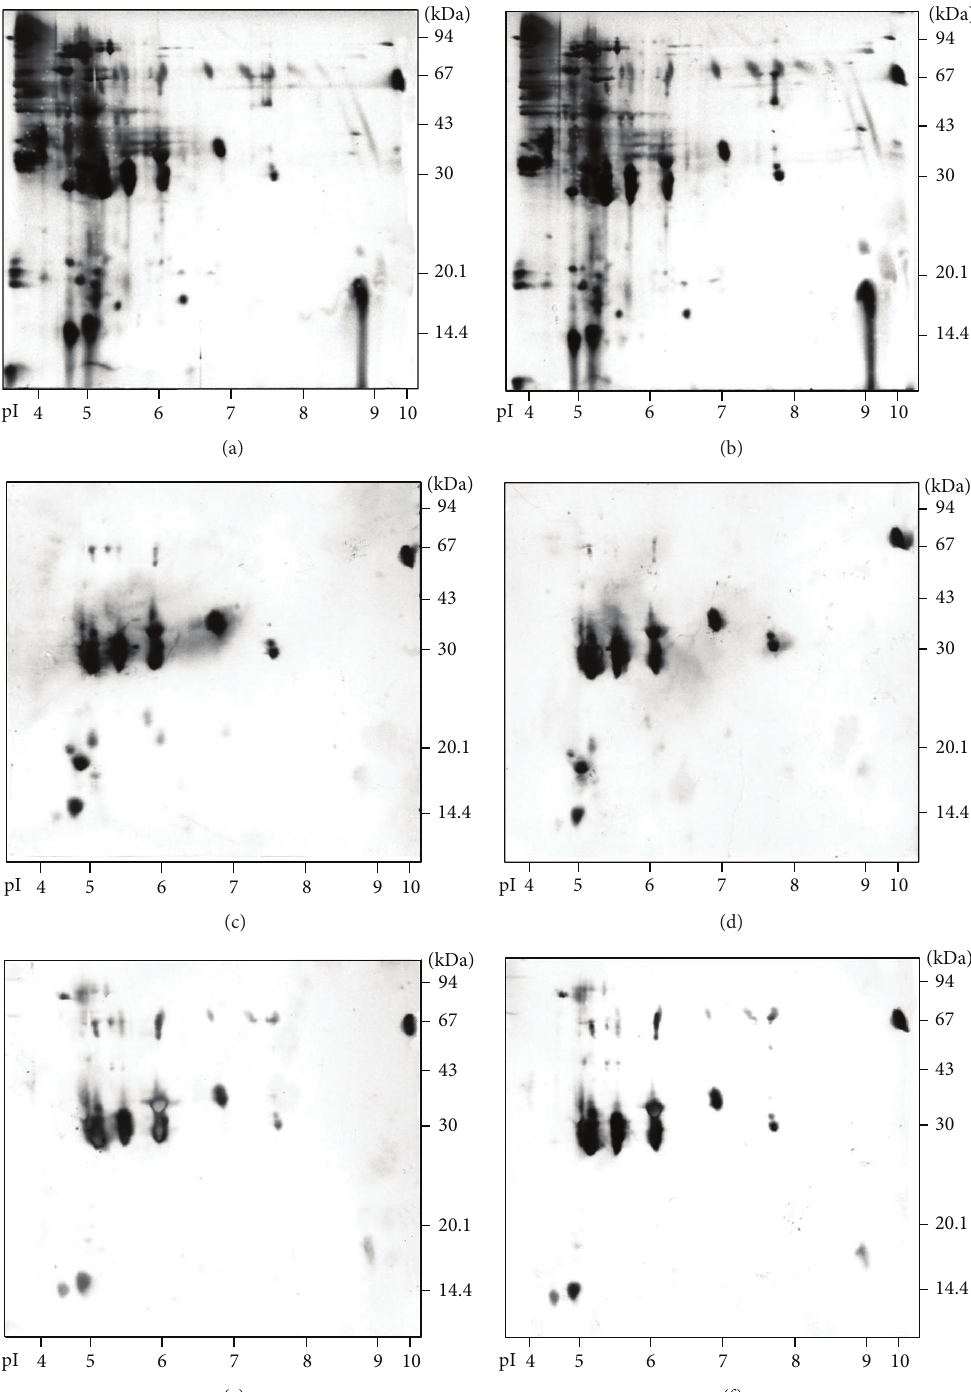
Figure 2: Two-dimensional gel electrophoresis analysis of the water-soluble proteins from Dactylis glomerata pollen harvested in ventilated greenhouse with air (a, c, e) or with air containing ozone, 100 𝜇 g/m 3 , 8 hours per day (b, d, f). Pollen extract from Dactylis glomerata was submitted to an initial isoelectrofocusing separation followed by gel electrophoresis with SDS. The gels were either silver stained (a, b) or transferred on nitrocellulose incubated with 2 different grass pollen-sensitized patient sera (c–f). IgE binding was revealed using heavy chain specific antibody coupled to alkaline phosphatase (AP). The AP activity was detected using 5-bromo-4-chloro-3-indolyl phosphate and nitroblue tetrazolium (Sigma) in 0.1M tris buffer pH 9.5. Isoelectric points (pI) values (at the bottom) and relative molecular mass (kDa, on the right) are indicated for each